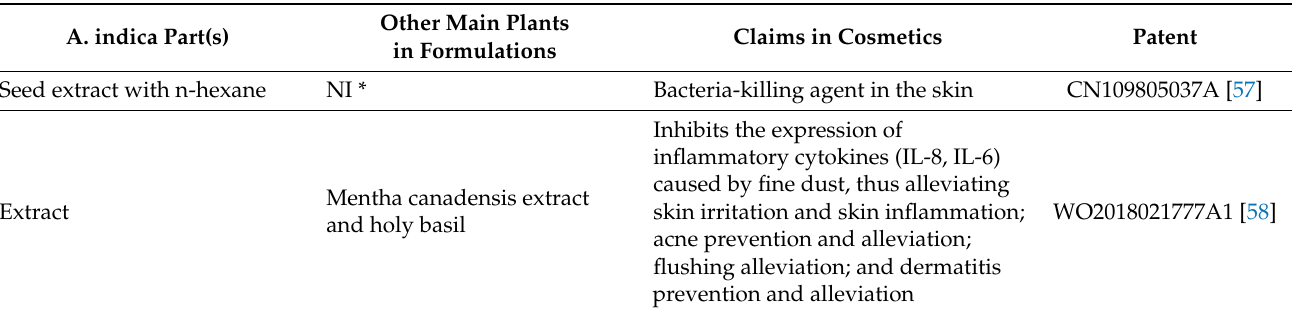
Table 3. Phytochemical structures of Azadirachta indica (Neem) parts with their cosmetic or topical